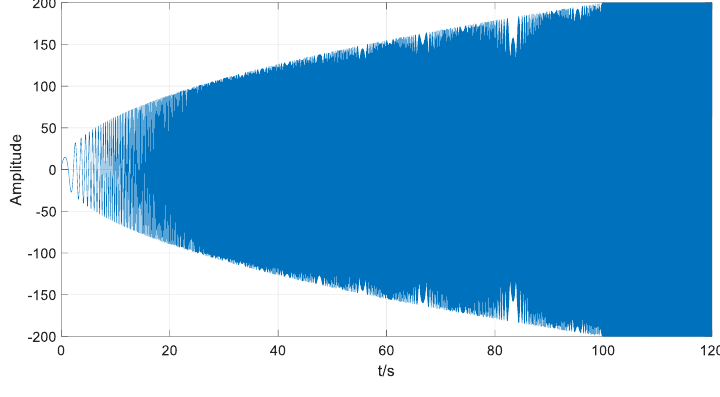
Figure 5. The generated simulated signal.